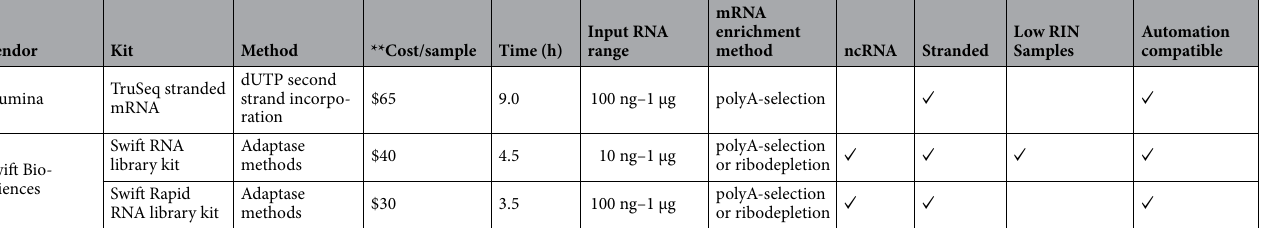
Table 1. Library preparation kit comparison and cost analysis. **Cost/sample includes costs of plastic consumables, the upstream poly-A selection kit, library prep kit, SPRI beads, and KAPA qPCR quantification